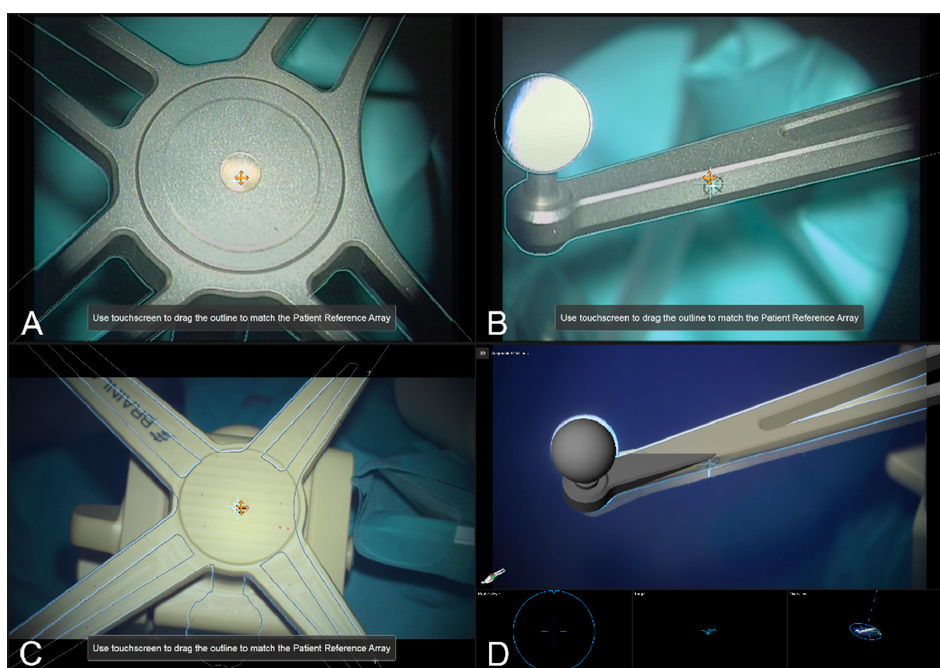
Figure 2. The AR representation of the cranial patient reference array visualizing matching the standard stainless-steel reference unit ( A , B ). The 2D and 3D AR representations overlaid onto the radiolucent cranial patient reference array used within the iCT set-up matching the central divot ( C ), and the spherical marker and calibration mark along the reference array’s arm ( D ). After calibration of the surgical microscope, AR-support including all pre-segmented